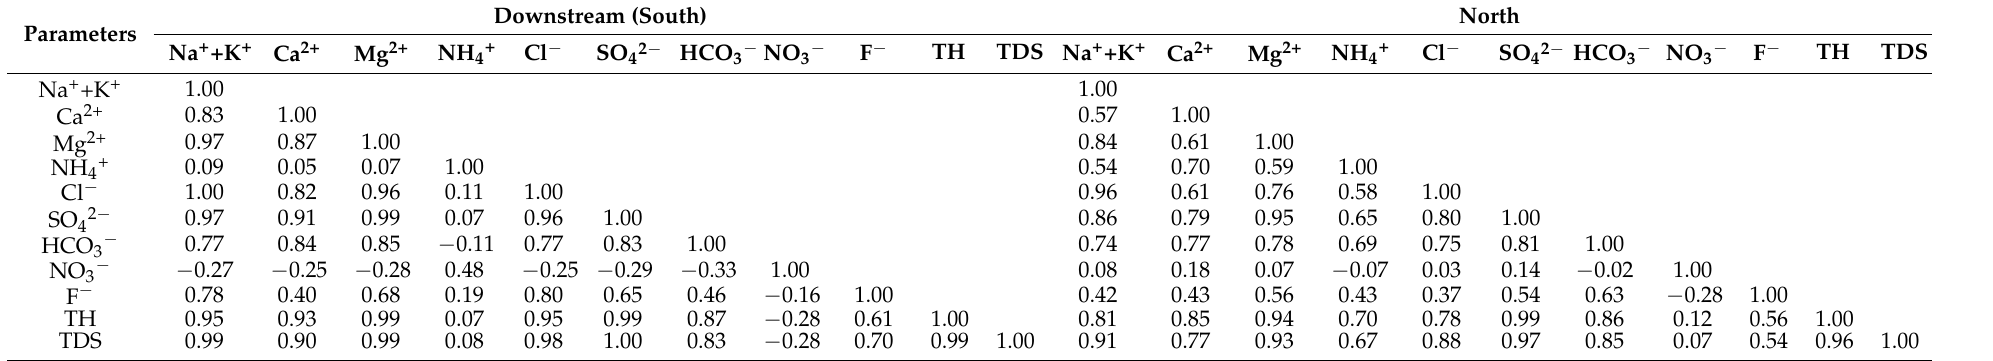
Table 4. Matrix of coefficient of correlation of the southern (downstream) and northern